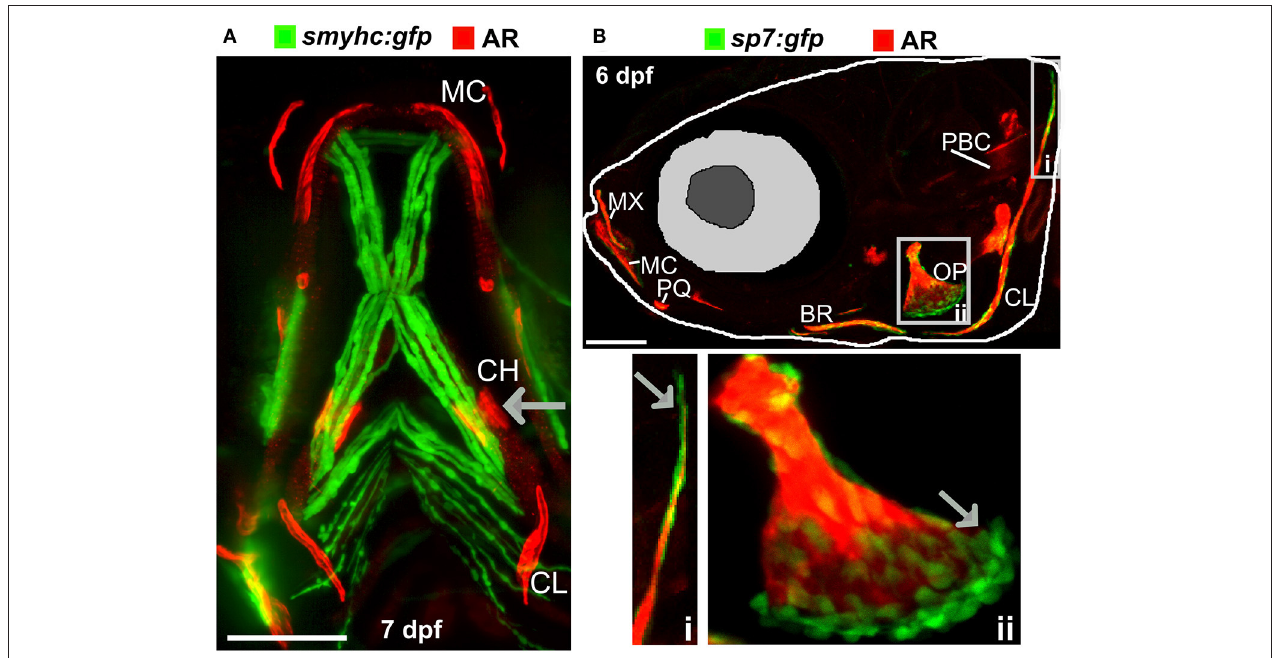
FIGURE 2 | Ossified elements in the cranial region during early development. (A) Ventral view of a 7 days live Alizarin Red S (AR) labeled larval jaw showing dermal ossification of cleithrum (CL), and ossification of the cartilaginous ceratohyal (CH). Arrow indicates the CH which undergoes endochondral ossification. Slow muscle transgene reporter in green ( smych:gfp ). Image taken on a Leica lightsheet microscope. (B) Lateral view of a 6 days old larva live labeled with Alizarin Red S (red) and carrying GFP under the control of the osteoblast promoter s7/osterix (green; sp7:gfp ) allowing visualization of mineralized elements (red) and osteoblasts (green) in a living individual. Insets show the cleithrum (i) and operculum (ii) with osteoblast enrichment at the distal ends of these elements (gray arrows). Image taken on a confocal microscope. Wildtype strains AB/TL in both panels. Ossified elements: BR, branchiostegal ray; CH, ceratohyal; CL, cleithrum; MC, Meckel’s cartilage; MX, maxilla; OP, operculum; PBC, posterior basicranial commissure; PQ, palatoquadrate. Scale bars = 100 µ m.